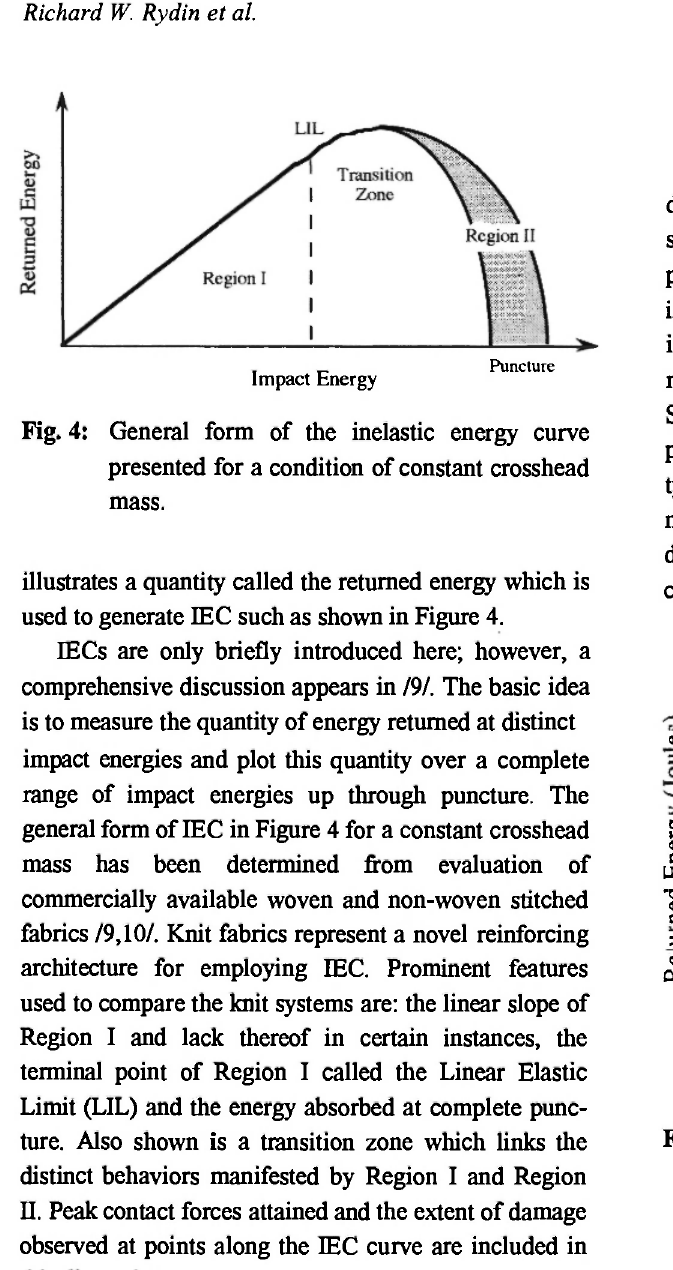
Fig. 5: Inelastic energy curves for single ply knit systems.